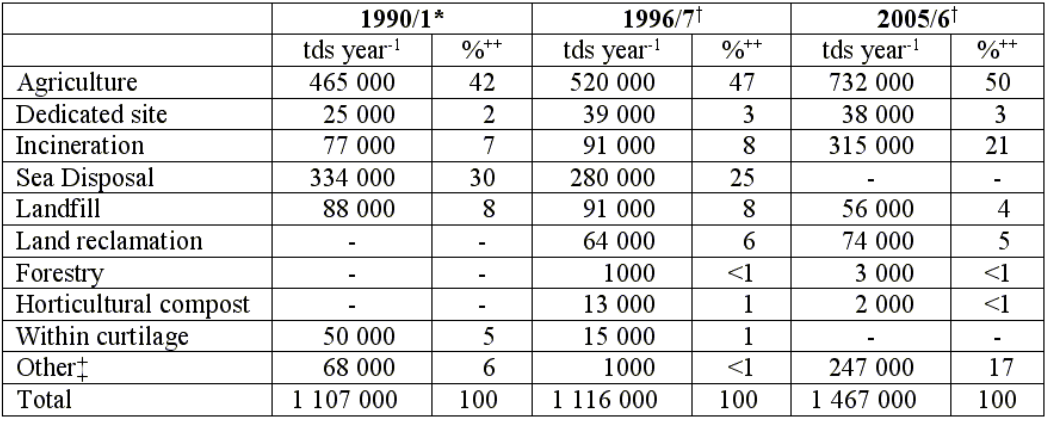
Disposal Outlets for Sewage Sludge in the U.K. in 1990/1, 1996/7, and Projected Figures for